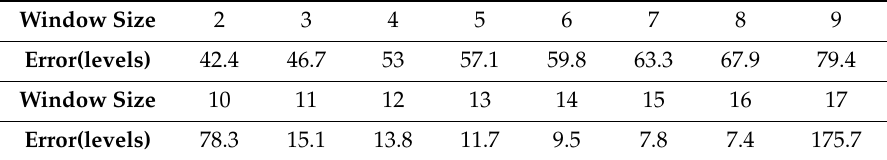
Table 1. The forecasting errors with di ff erent moving average window